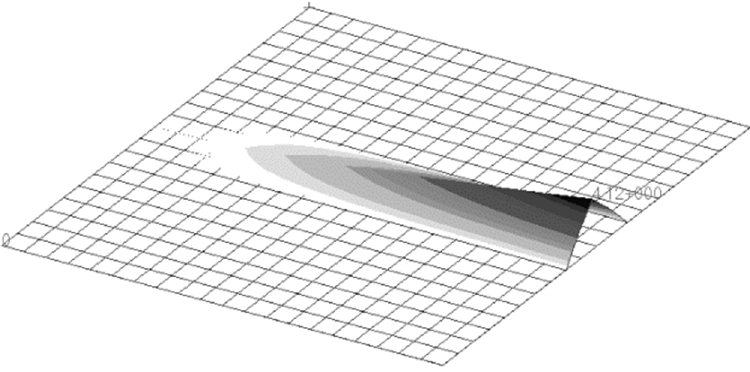
Figure 6. The displacements result of the static analysis (Max dis = 4.12 m).